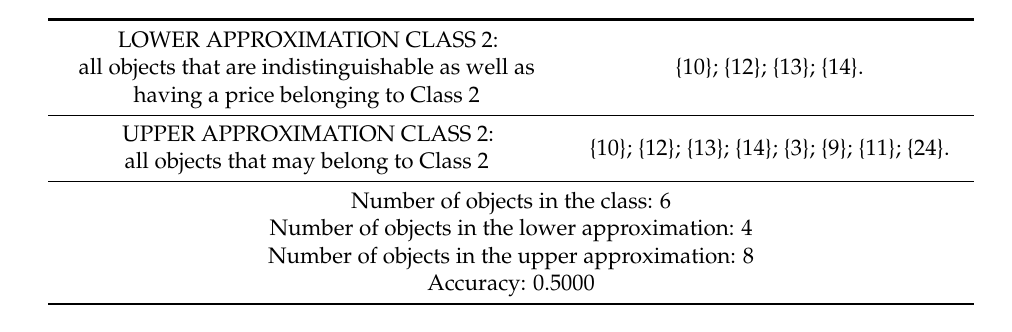
Table 6. Lower and upper approximations for Price Class 2.